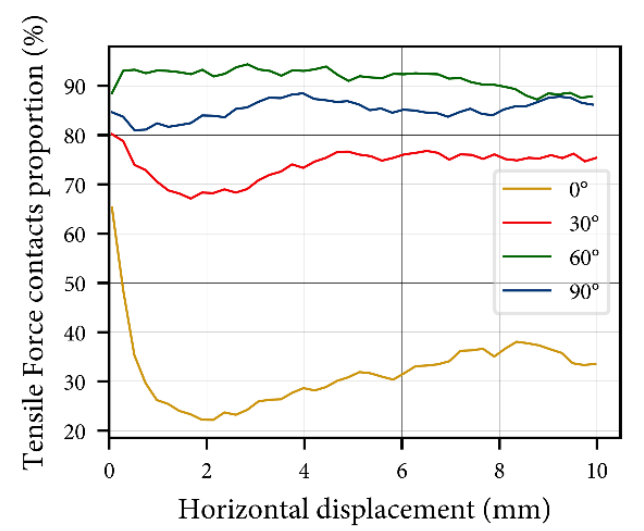
Figure 16. Tensile force contact percentage in fibers.